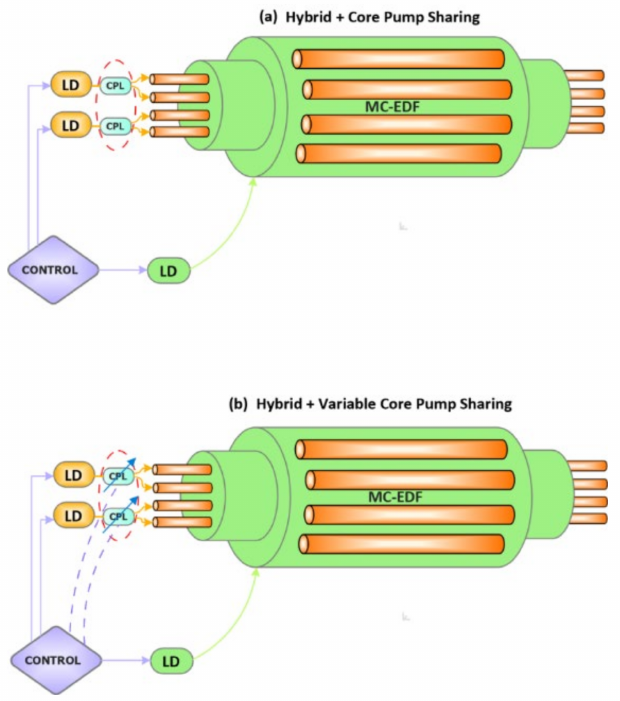
Figure 24. ( a ) Hybrid + core pump-sharing. ( b ) Hybrid + variable core pump-sharing methods for